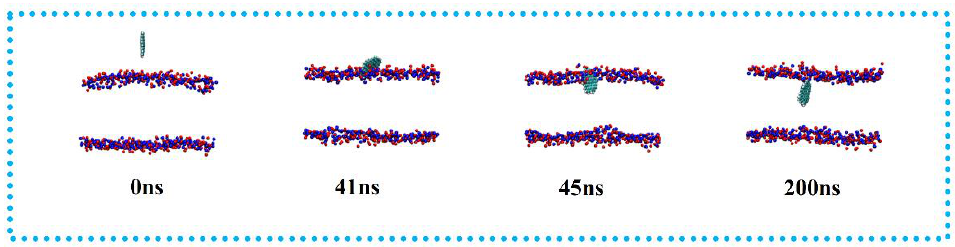
Figure 5. Penetration of GQDs on POPE-LD membrane.